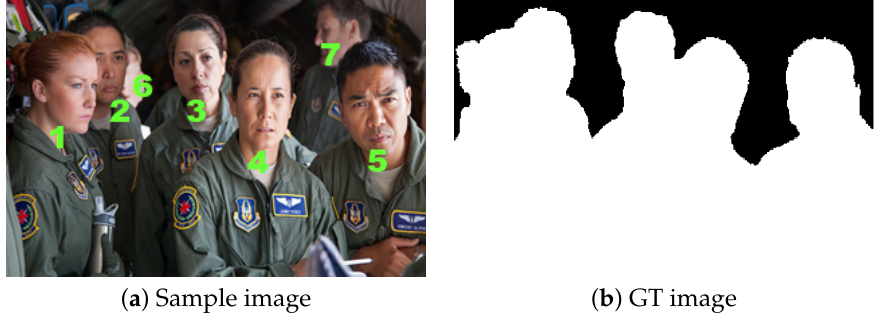
Figure 2. The figure represents the two images, i.e., the original sample image along with its respective GT image. The sample image numerically identifies the blurred and non-blurred objects: the non-blurred objects are represented by 1, 2, 3, 4, and 5, respectively, whereas the rest are blurred objects. In the GT image, white indicates the non-blurred objects, whereas the black spots identify the blurred